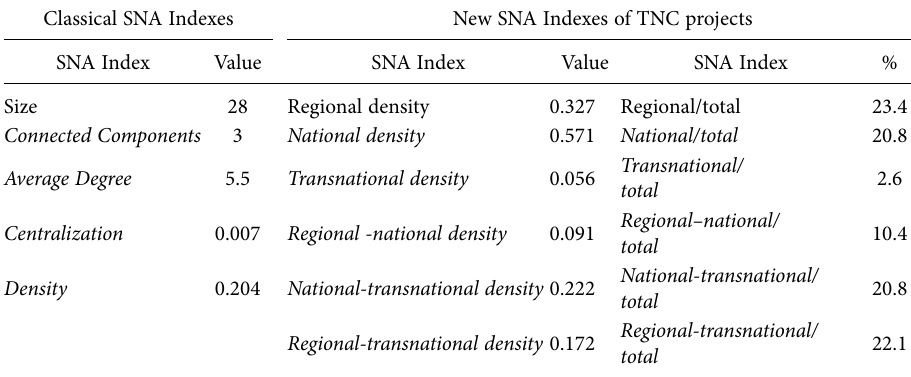
Table 9. Indexes of the transnational cooperation network of Veneto LAGs, LEADER Axis. Classical SNA Indexes